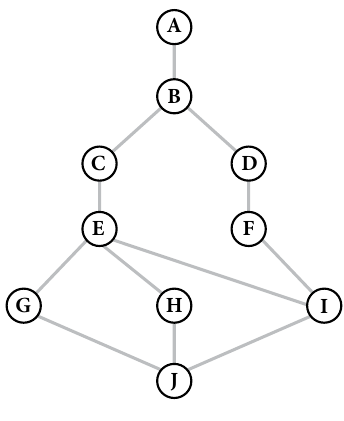
Fig. 2. A network for the explanation of